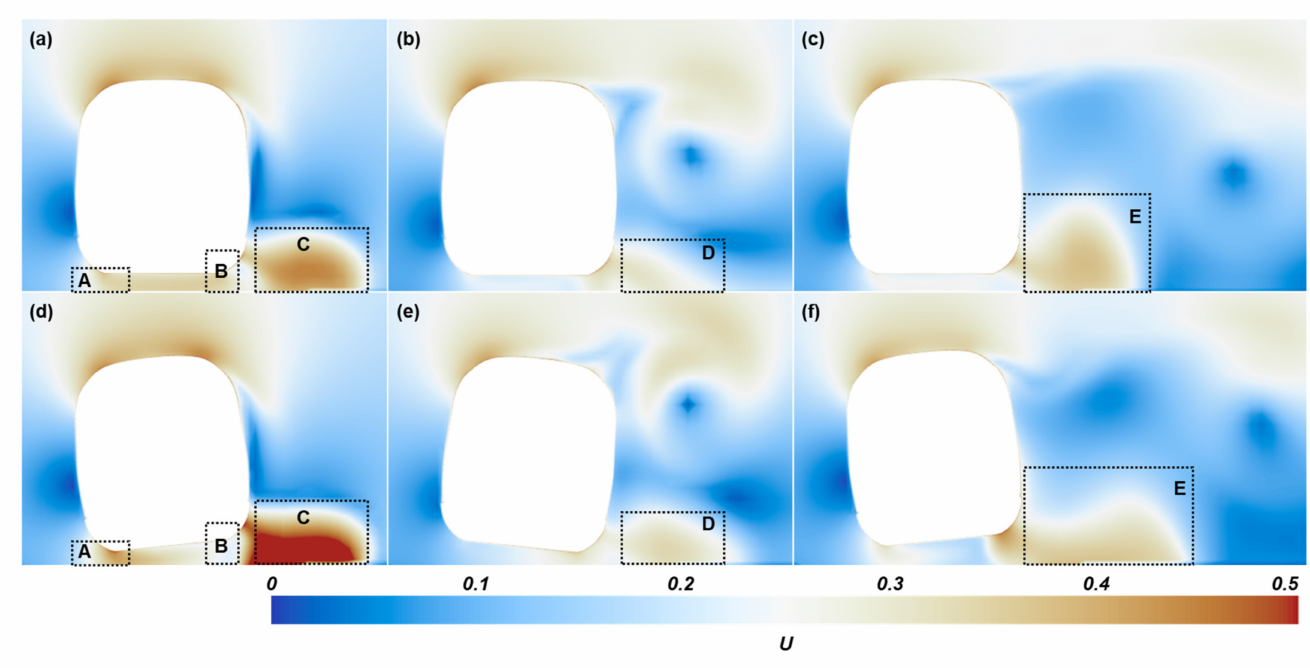
Figure 9. Distribution of U projected on the y–z plane at the middle length of: ( a ) the leading car of the original train; ( b ) the middle car of the original train; ( c ) the trailing car of the original train; ( d ) the leading car of the train with posture; ( e ) the middle car of the train with posture; ( f ) the trailing car of the train with